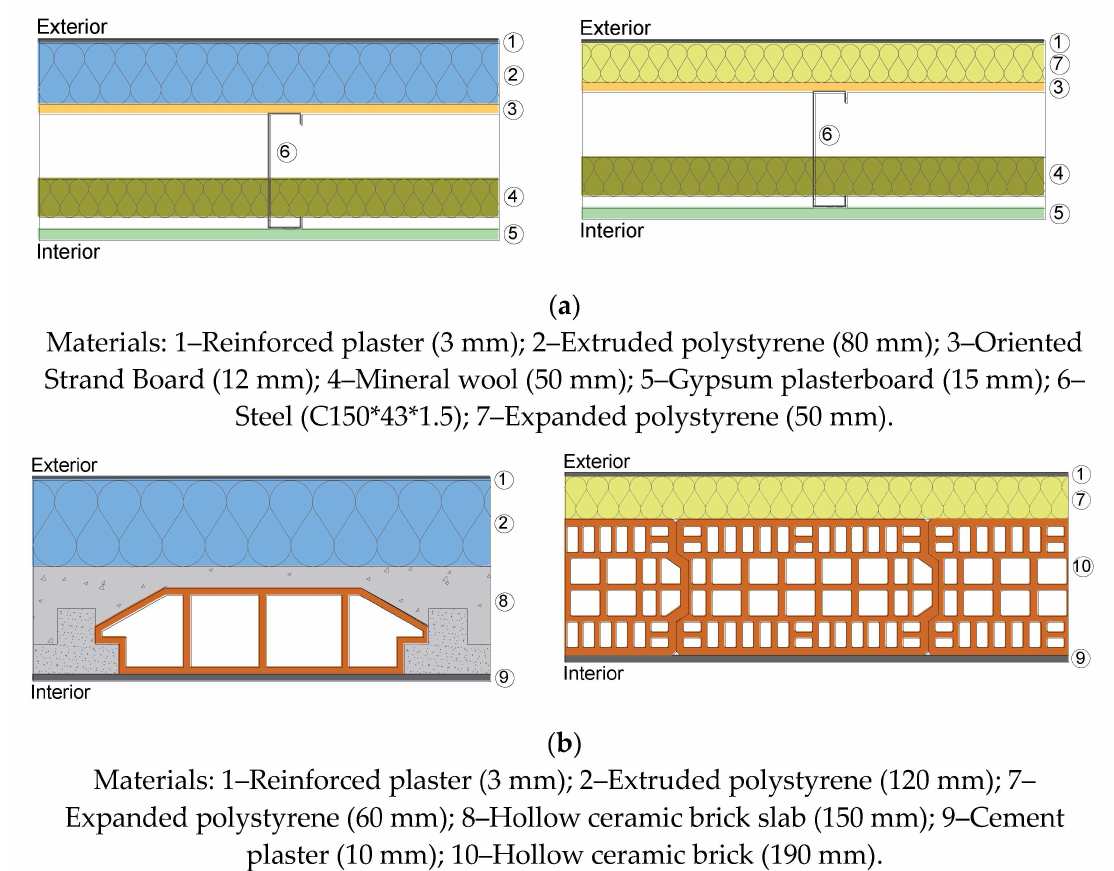
Figure 2. Constitution of the opaque external envelope elements: ( a ) LSF experimental test cell; ( b ) HBM experimental test